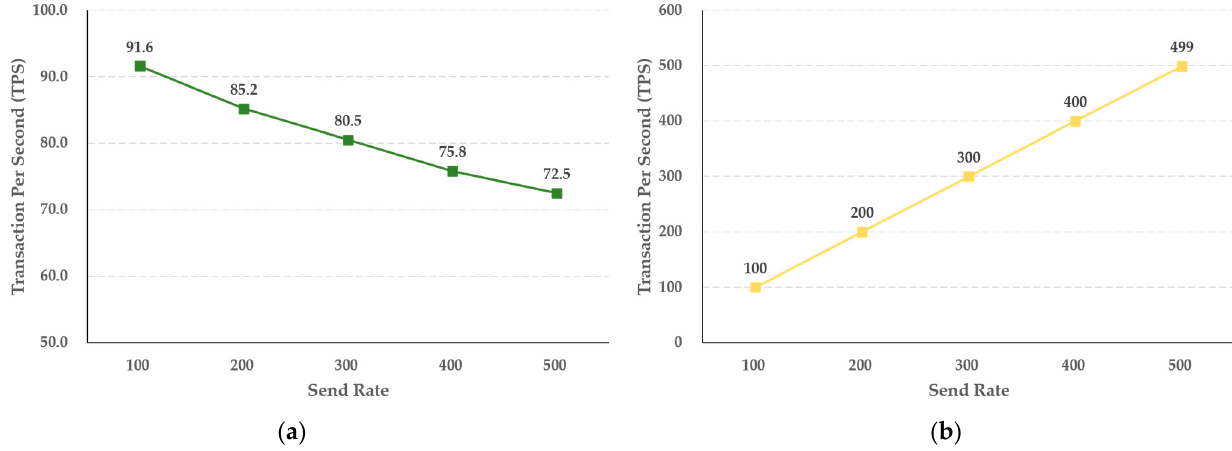
Figure 9. Results of ( a ) saving and ( b ) selecting the performance of identity and investigation information in the hot blockchain by send rate.